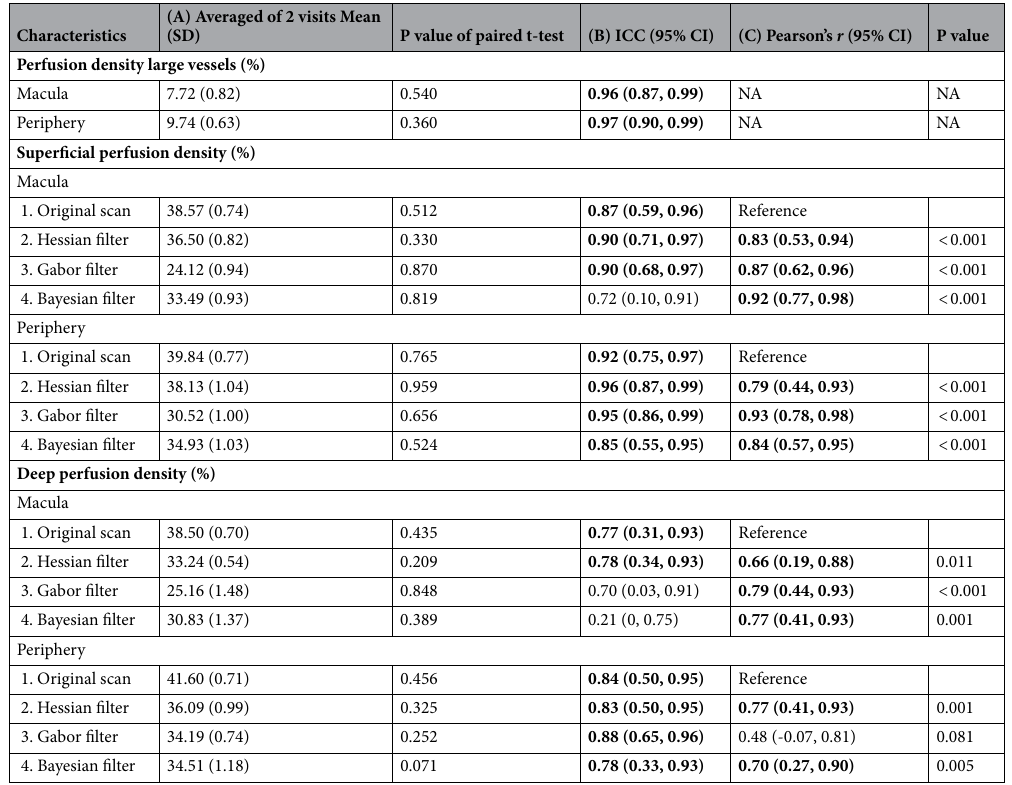
Table 1. OCTA vascular parameters of the retinal plexus. Bold interface indicates the filter that provided good ICC (≥ 0.75) and P < 0.05 for Pearson’s correlation when compared to the original scan for each category. SD standard deviation; CI confidence interval; ICC intraclass correlation